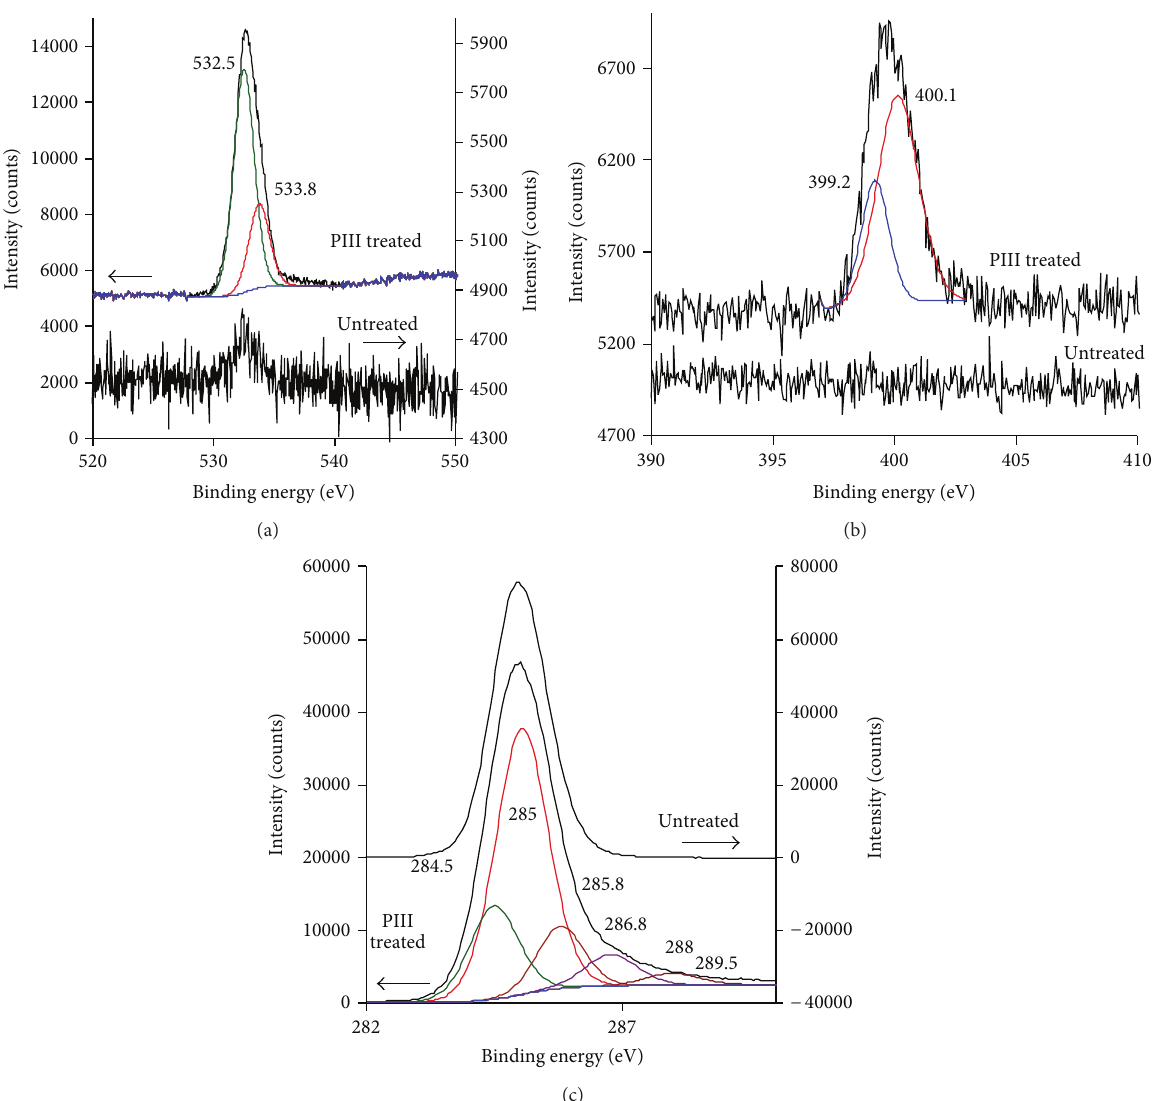
ions/cm lines: 16 s line of XP� �tted spectra of UHMWPE before and aer PIII s �uence. e untreated polyethylene does not contain nitrogen. e PIII-treated 1 line of XP� �tted spectra of 2 s ions/cm �uence. e untreated polyethylene has singlet 1 lines: 284.5eV and 285eV of hydrocarbon bonds, and 285.8, 286.8, 16 2 s 1